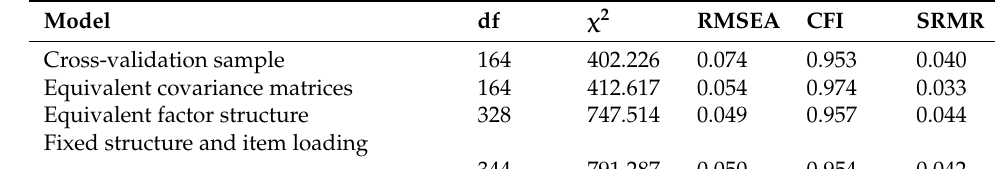
Table 5. Fit Indexes for cross-validation and invariance analyses.